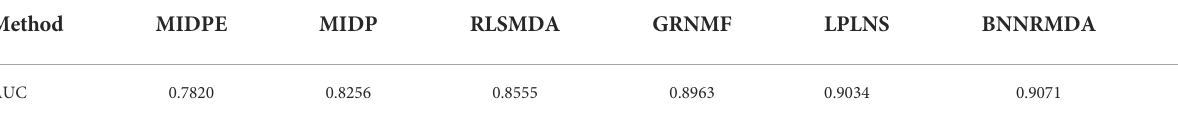
TABLE 1 AUCs of microRNA-disease association prediction methods under cross validation.